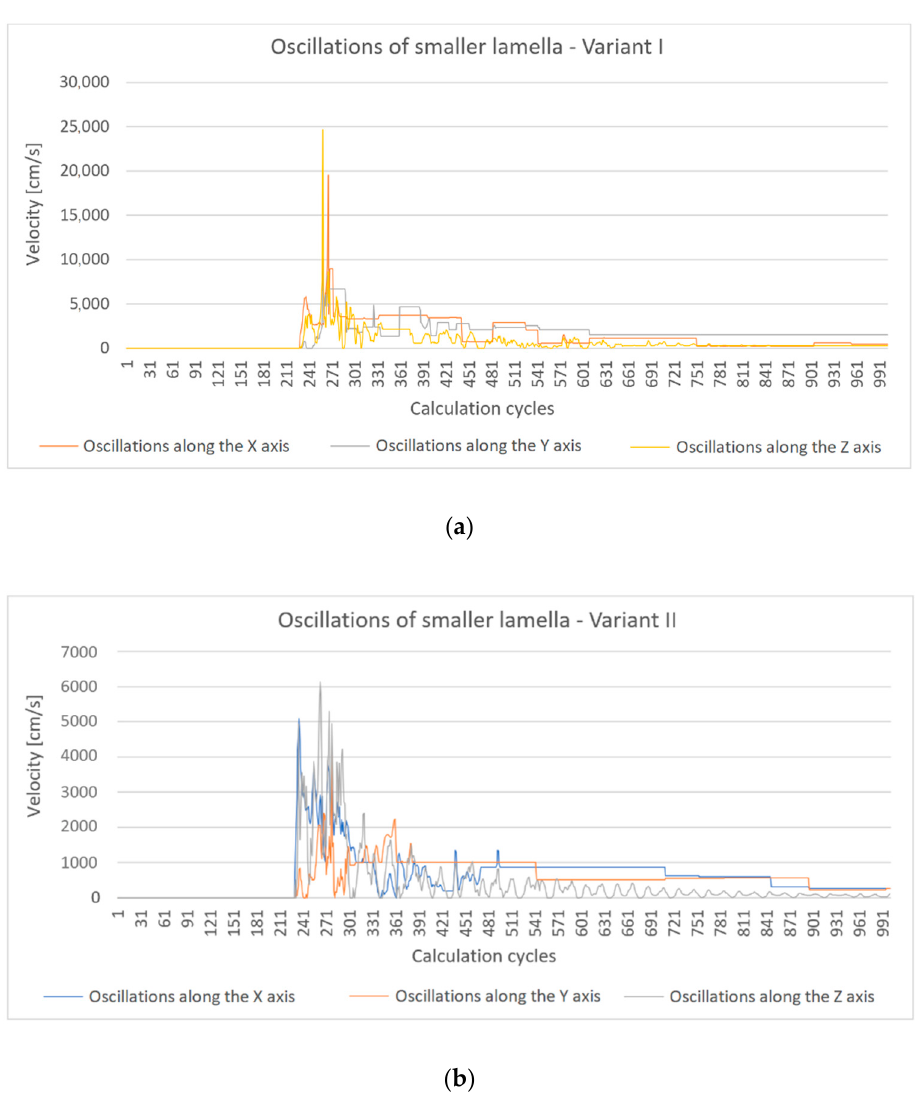
Figure 19. View of the small lamellas’ oscillations before and after modification in each plane: ( a ) Variant I and ( b ) Variant II.